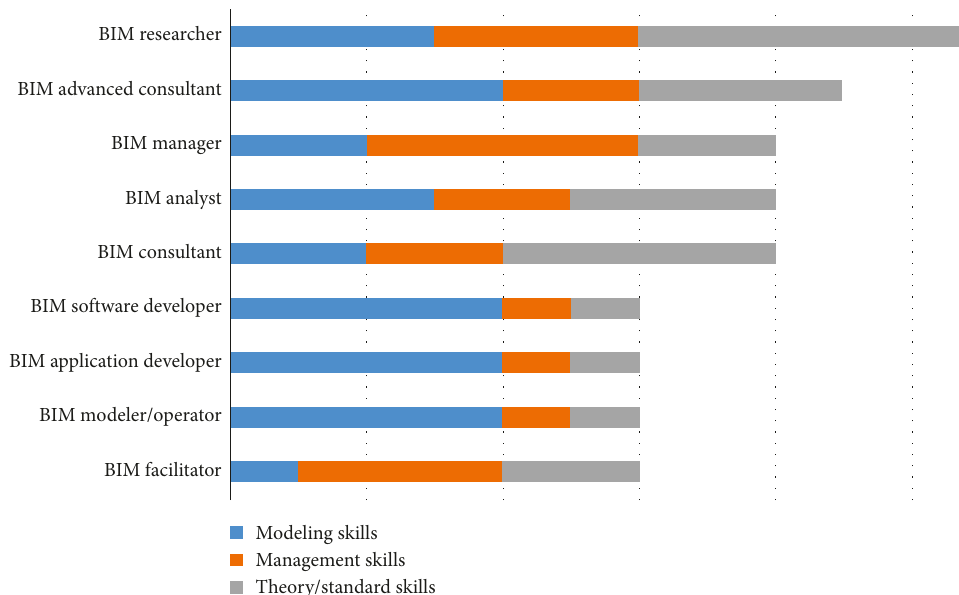
Figure 1: A distribution of the weights of BIM-specific knowledge expected for different BIM specialists